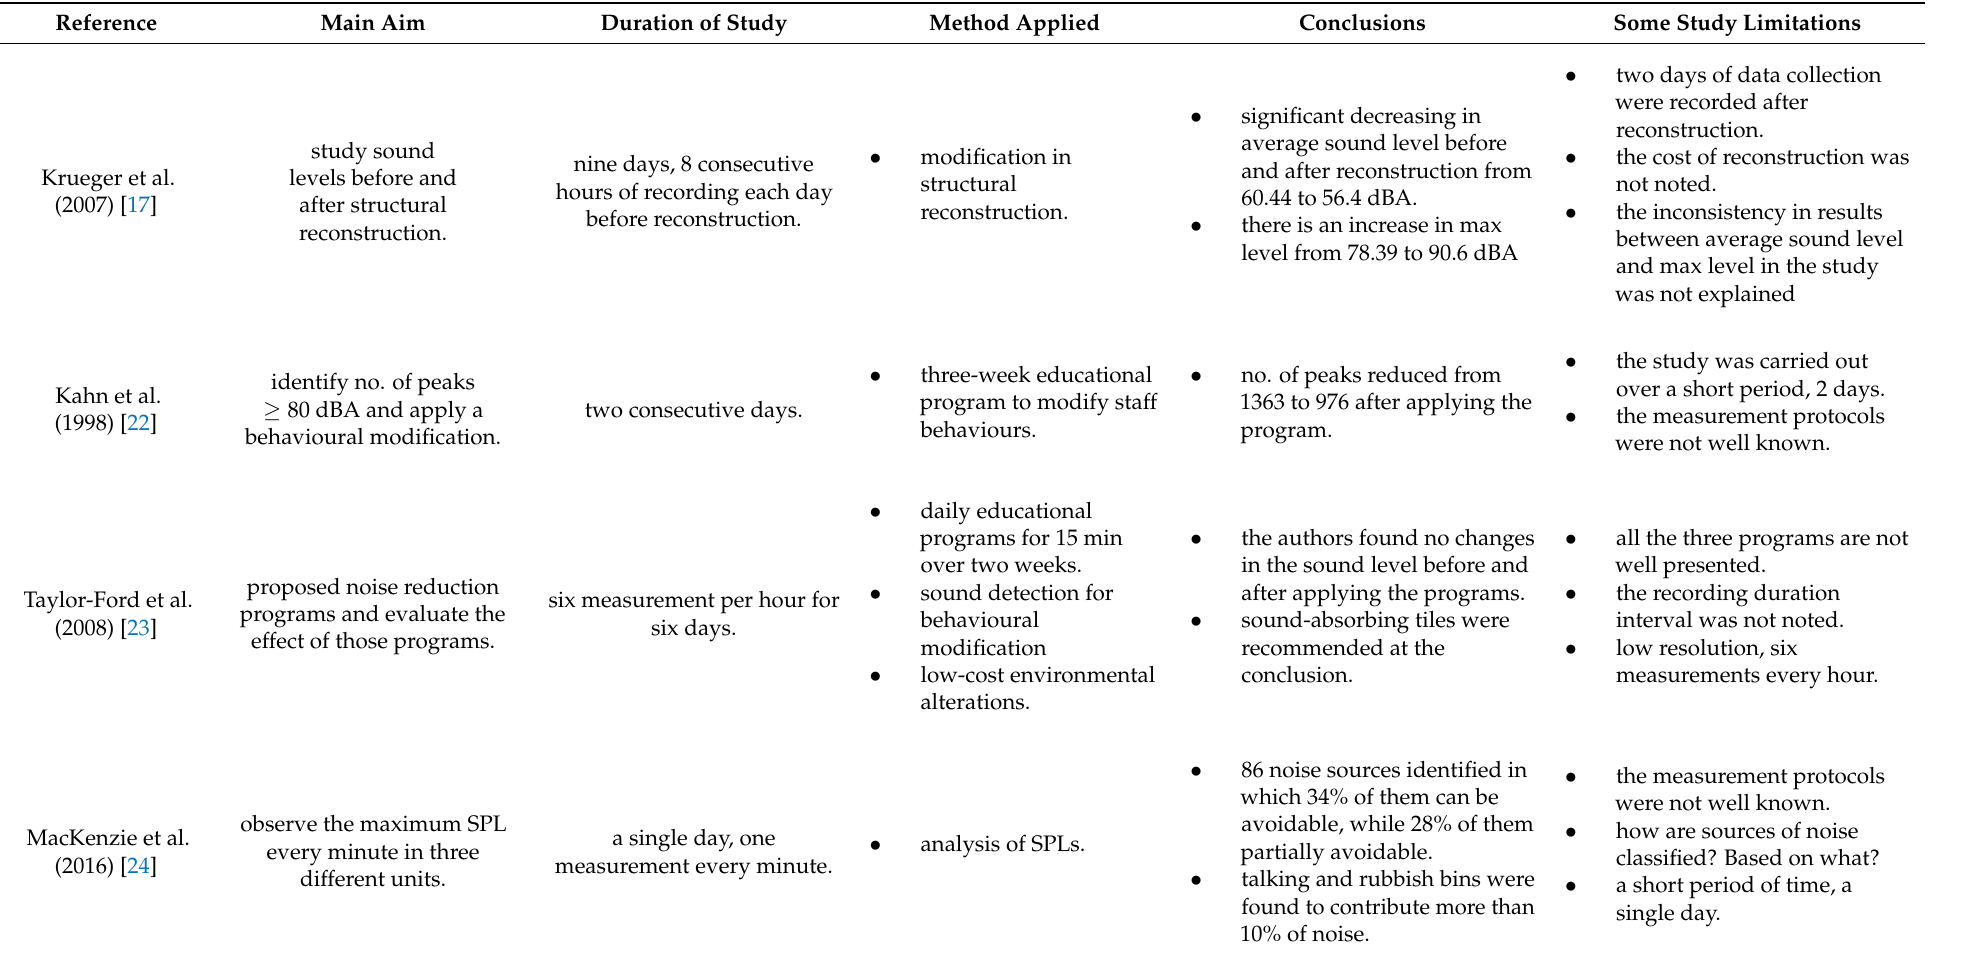
Table 2. Summary of the studies and corresponding passive techniques used to reduce ICU noise